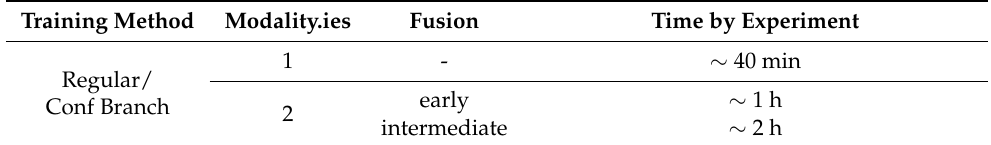
Table A8. Experimental setup.